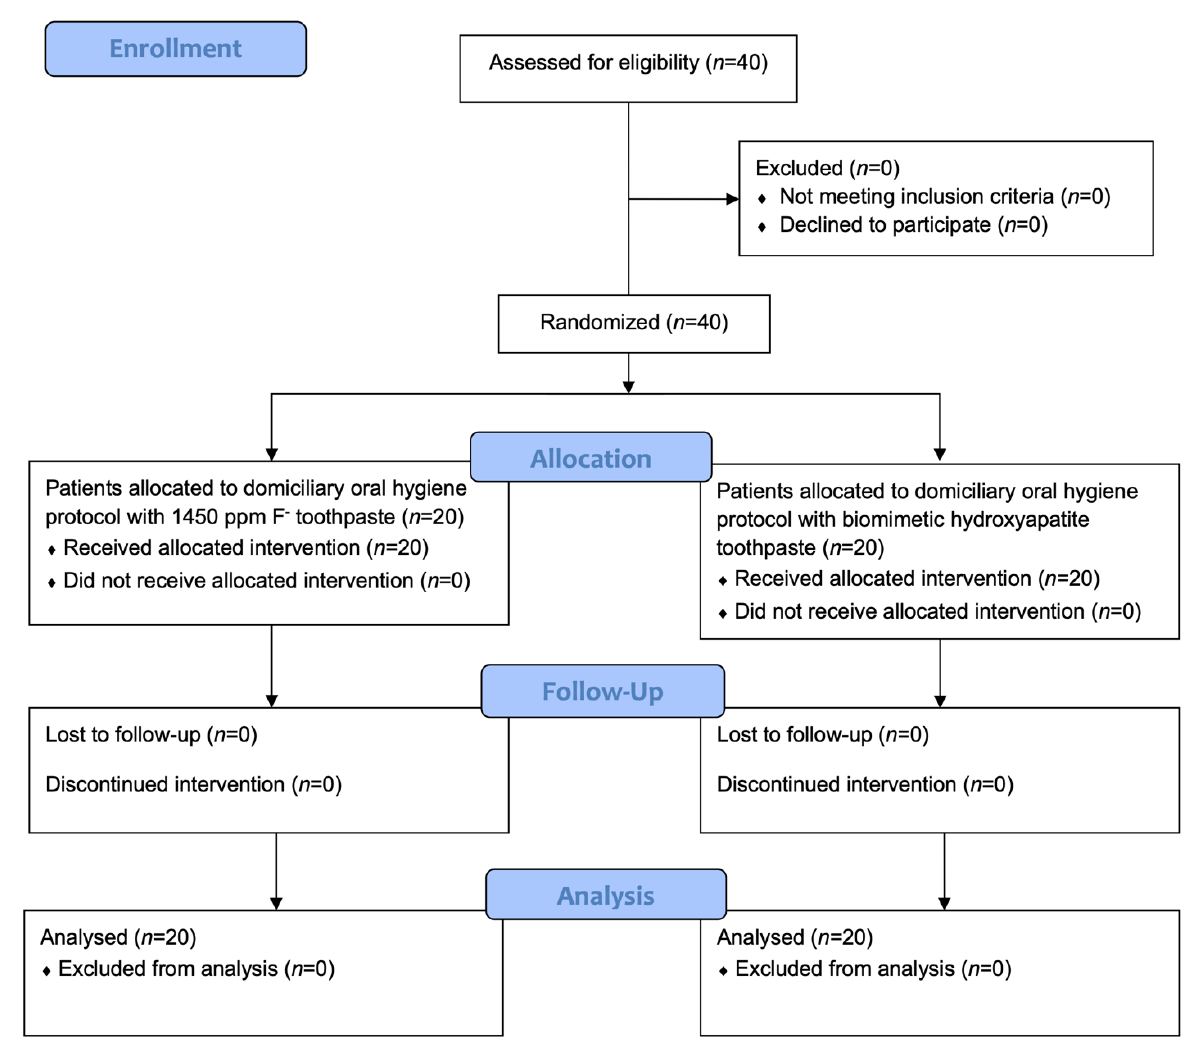
Figure 1. CONSORT flow chart. Table 3. Baseline demographic